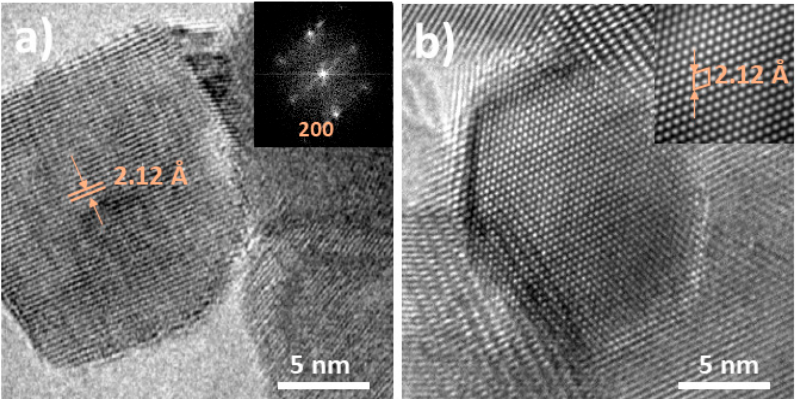
Figure 4. HRTEM images from undoped NiO sample. ( a ) Isolated NiO nanoparticle with the corresponding SAED pattern, and ( b ) NiO nanoparticle with atomic resolution and the corresponding I-FFT, confirming the NiO cubic structure.